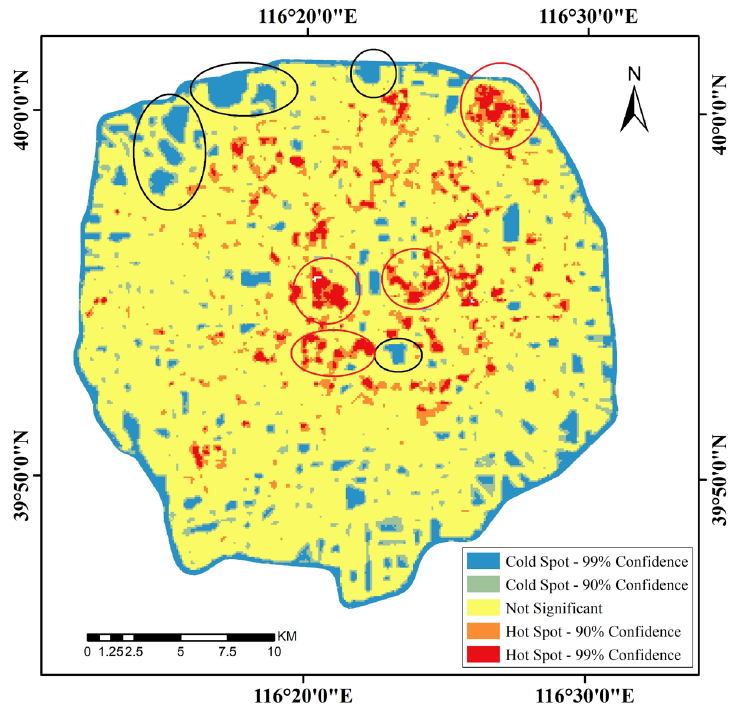
Figure 12. Hot and cold spots of SSSBI. The red circle part is the hot spot area, and the black circle part is the cold spot